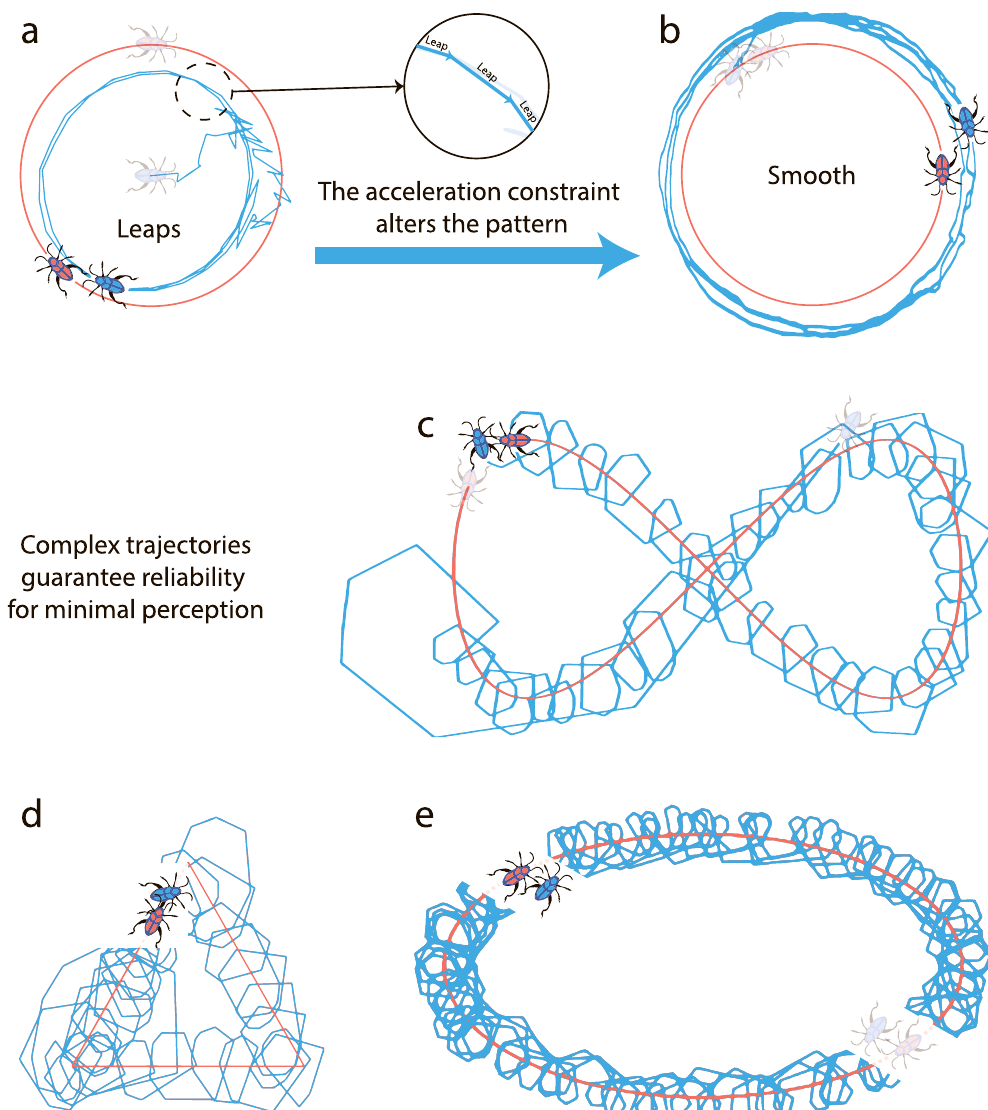
Figure 2. ( a ) The typical trajectory of the follower after the training for A-scenario of escort—the follower can perceive its absolute velocity without a limitation for the acceleration. Note the “frog-strategy” of the follower (see the text). ( b ) The typical trajectory of the follower after the training for B-Scenario of escort—the follower can perceive its absolute velocity and its acceleration is limited. The follower moves on a relatively smooth trajectory. ( c – e ) The typical trajectory of the follower after the training for C-scenario of escort—the follower can perceive only its acceleration and the acceleration is limited. The trained follower moves on wrapping trajectories for all trajectories of the leader—circular (not shown), eight-curve ( c ), triangular ( d ) and elliptic ( e